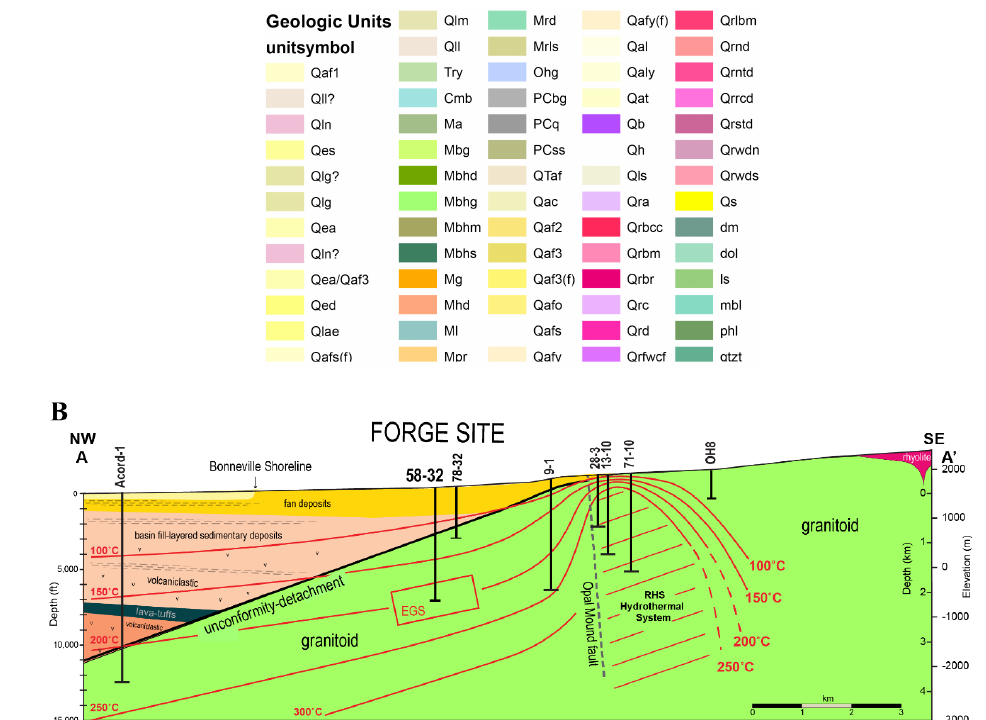
Figure 1. ( A ) Geologic map of the FORGE site and surrounding area (modified from [9], the name of the publisher: Geological Society of America; and [15], the name of the publisher: Utah Geological Survey). For clarity, only a few of the many wells are shown. Abbreviations: Qa-1 = Lake Bonneville silts and sands, Qa-2 = alluvial fan deposits, Qr = Quaternary rhyolite lava and pyroclastic deposits, Tg = Tertiary granitoid, PC = Precambrian gneiss, and black filled circles = wells. ( B ) Northwest-southeast section through the FORGE site [16]. The Roosevelt Hot Springs (RHS) geothermal system lies east of the Opal Mound fault. Isotherms are interpreted from well measurements. The red box represents the approximate position of the FORGE enhance geothermal system (EGS) reservoir.